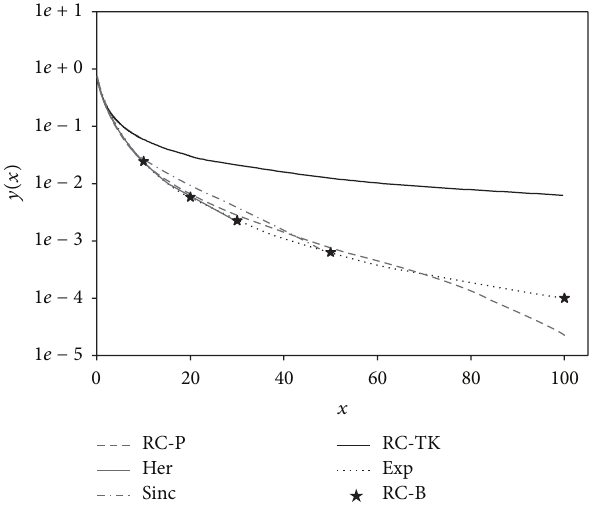
Figure 1: Graphical representation of results given in Table 2. Figure 2: Comparison of convergence speeds for different methods, corresponding to the number of basis functions ( 𝑁 ) used, for calculatingtheinitialslope 𝑦 󸀠 (0) .Theexponentialbasissetisdefined with the following parameters: 𝑠 = 5 , 𝑑 𝑠 = −4 , and 𝑑 𝑙 = 2